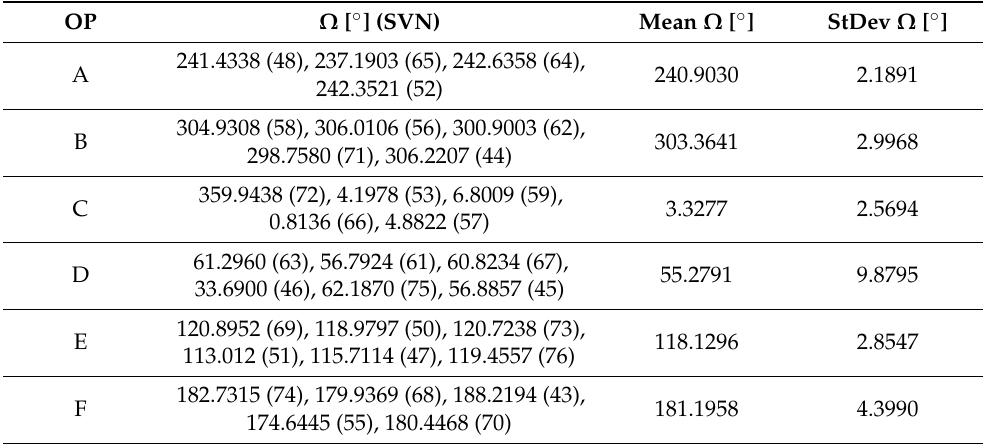
Table 1. The assignment of satellites to orbital planes on the example of the GPS time third cycle almanac from epoch